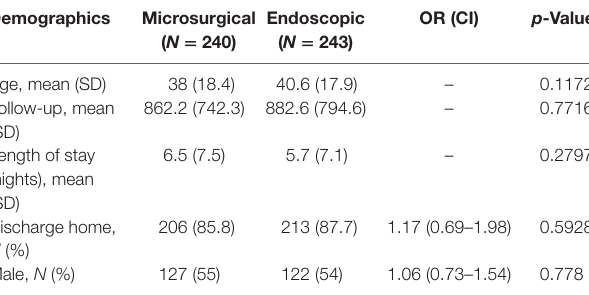
Table 2 | Patient